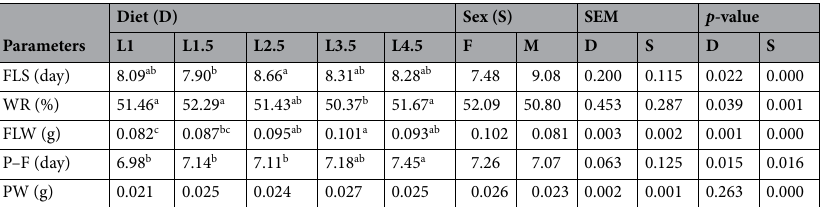
Table 3. Effects of the diet and sex on adult parameters. D diet, S sex, F female, M male, L1 EE 1% diet, L1.5 EE 1.5% diet, L2.5 EE 2.5% diet, L3.5 EE 3.5% diet, L4.5 EE 4.5% diet, SEM standard error of the mean, FLS fly